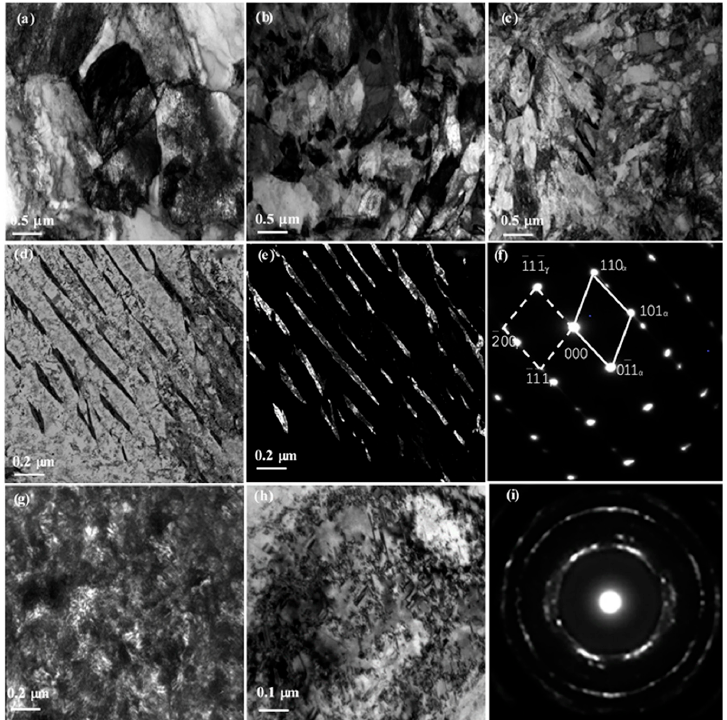
Figure 2. TEM images of final microstructures for ( a ) CHR-Q&P, ( b ) AHR-Q&P and ( c ) AHR-DQ-Q&P steel; ( d – f ) TEM images of final microstructures for AHR-DQ-Q&P steel, ( d ) bright-field TEM images of film-like morphology retained austenite (RA), ( e ) dark-field TEM images and ( f ) selected area diffraction pattern (SADP); ( g – i ) TEM images of cold-rolled martensite for AHR-DQ-Q&P steel, ( g ) cold-rolled martensite, ( h ) enlargement of selected area in ( d ), ( i ) corresponding to